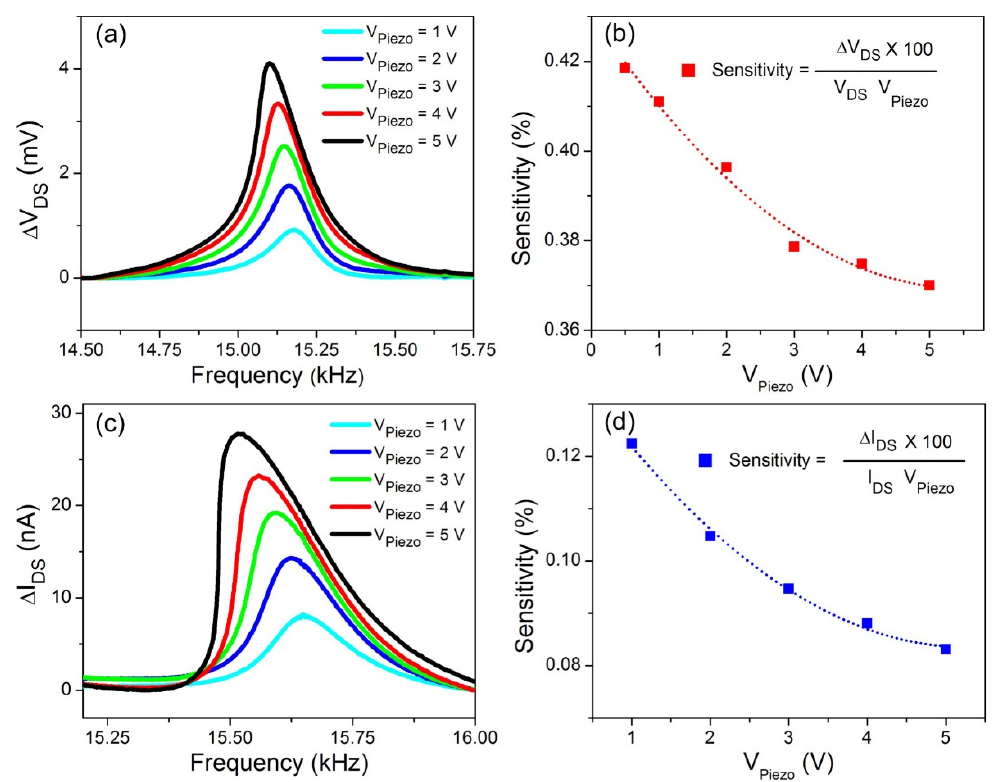
Figure 4. Effects of the excitation amplitude on resonance curves at room temperature and pressure. ( a ) Dynamic resonance characteristics of AlGaN/GaN HFET embedded GaN microcantilevers, at various piezoactuator biases. The resonance frequency of the cantilever shifts to lower frequencies as the excitation signal amplitude increases, due to dominant softening nonlinearities. ( b ) Changes in the AlGaN/GaN HFET sensitivity monotonically reduces as the applied piezoactuator bias is increased. ( c ) Effects of piezoactuator bias on the resonance characteristics of the VO 2 thin film deposited GaN microcantilever. Similar to the AlGaN/GaN HFET embedded cantilever, softening nonlinearity also reduces the resonance frequency. ( d ) Sensitivity of VO 2 thin film based displacement transducer reduces as the piezoactuator bias increases, similar to the HFET embedded cantilever. The tip oscillation amplitude ( x 0 ) at the resonance frequency of ω 0 is given by x 2